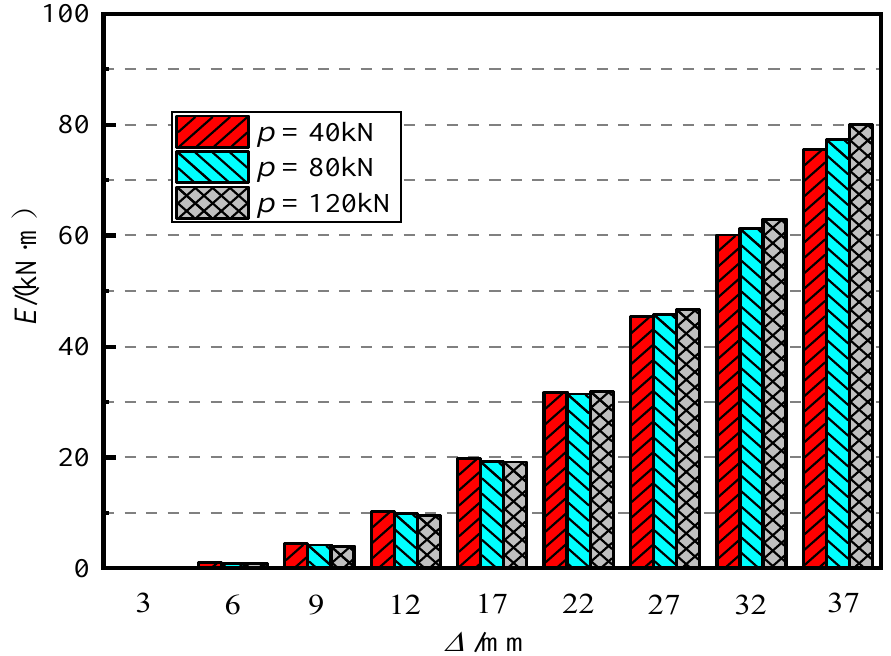
Figure 18. Cumulative energy consumption.